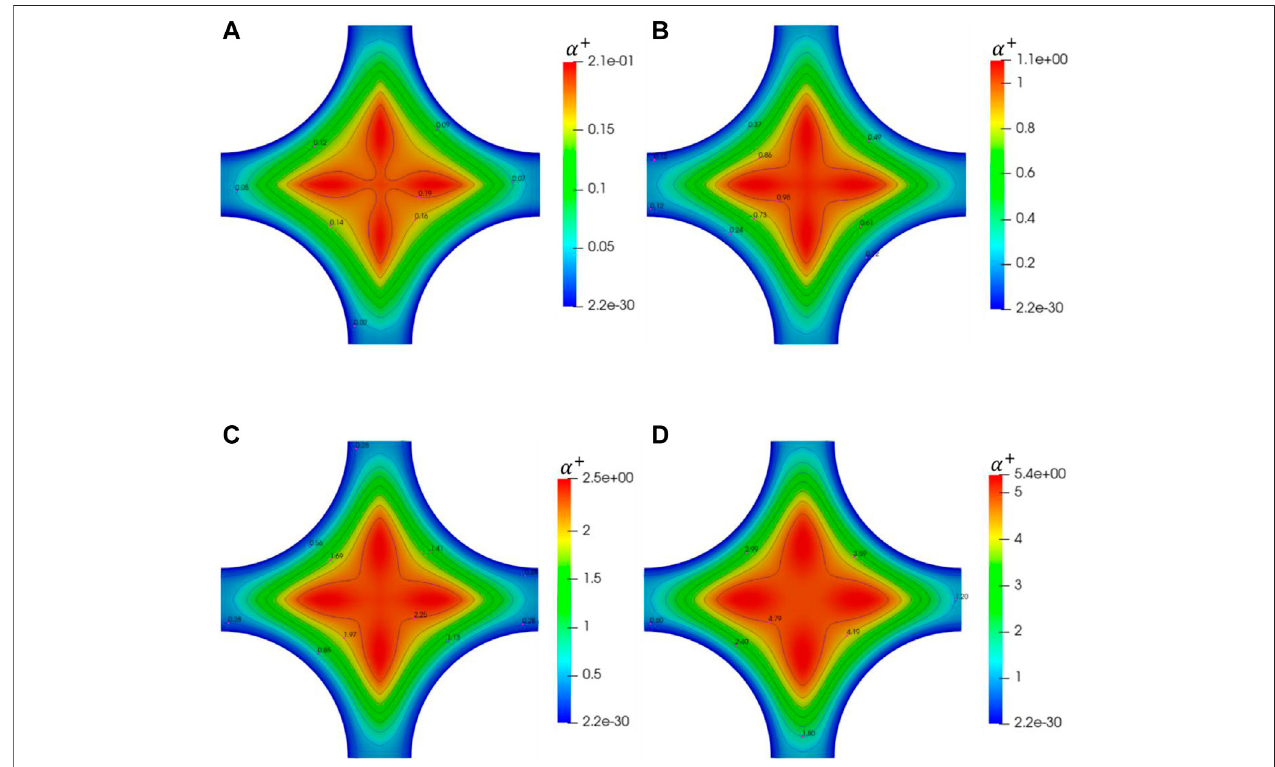
FIGURE 13 | Schematic diagram of dimensionless thermal diffusivity on a slice for square lattice X = 1.25. (A) Pe = 250; (B) Pe = 1000; (C) Pe = 2000; (D) Pe = 4000.